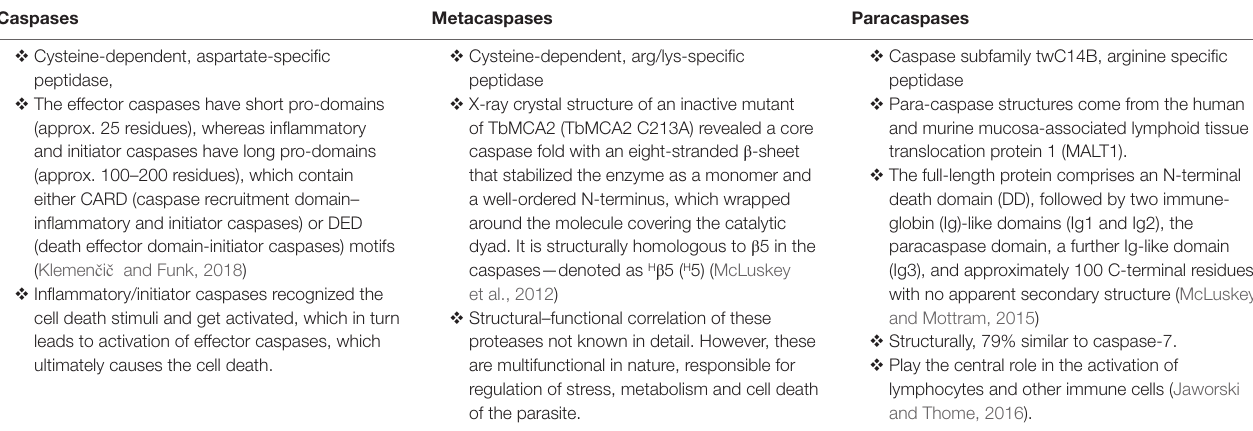
TABLE 2 | Structural–functional analyses of caspases, metacaspases, and